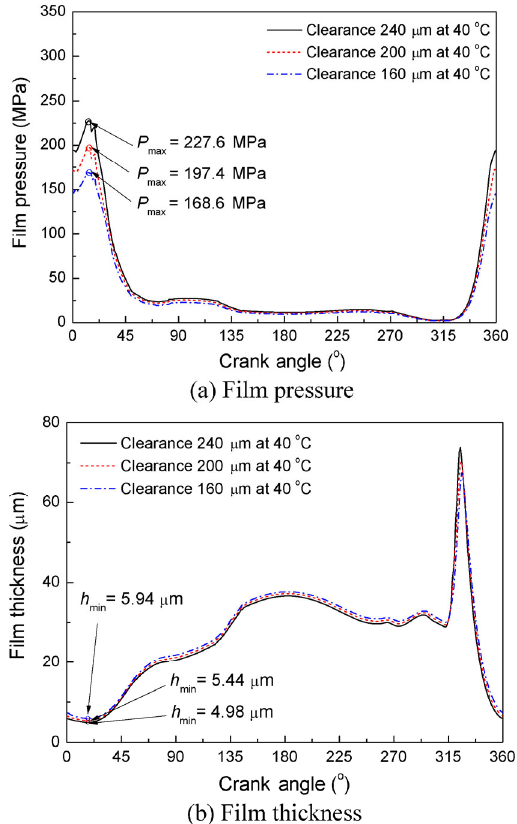
Fig. 10 Pressure and film thickness with the crank angles for the crank pin bearing with a clearance of 240 μ m at three different lubricant